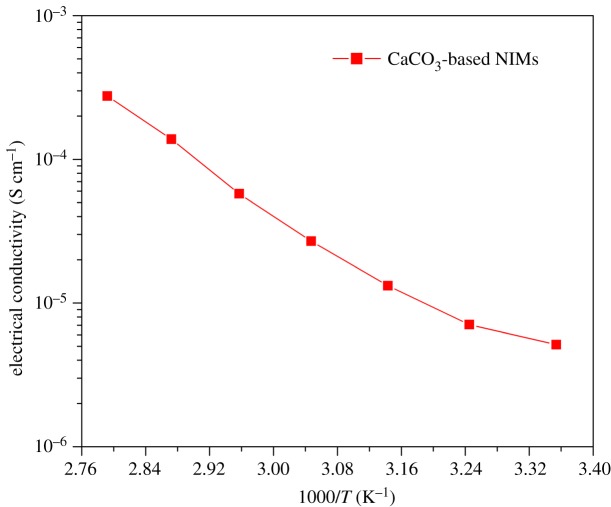
Logarithmic plot of σ versus 1000/T for CaCO3-based NIMs.